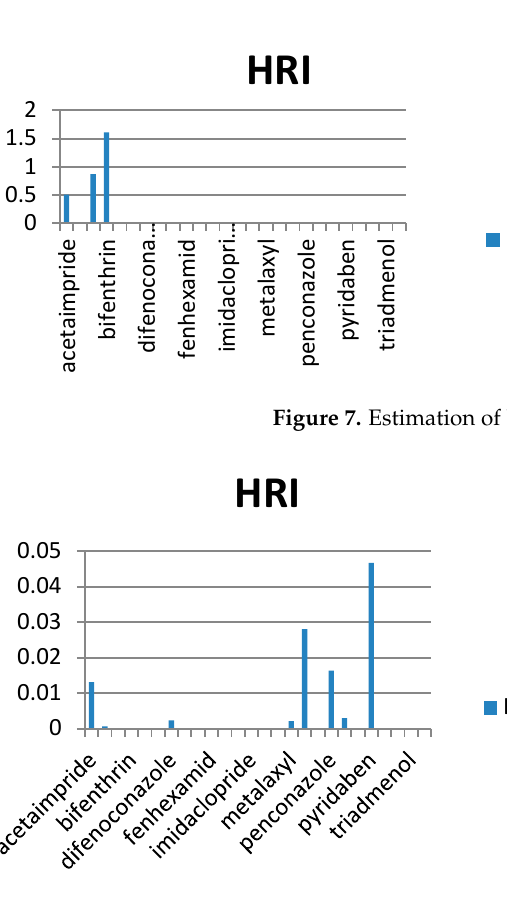
Table 3. Estimation of EDI and HRI for pesticide residues detected in Tomato, Sweet pepper, Squash and Cucumber samples.